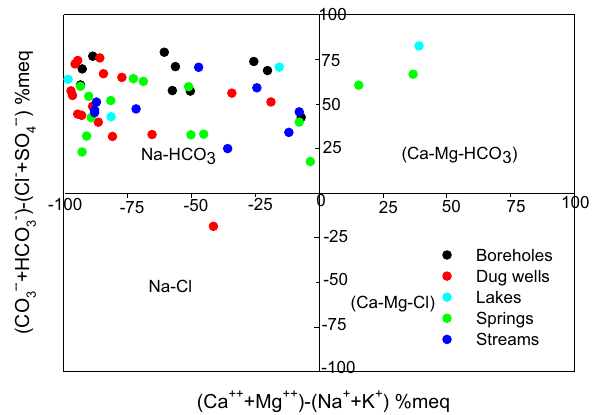
Fig. 18 Chadha’s diagram for hydrogeochemical classification of water types in Meru